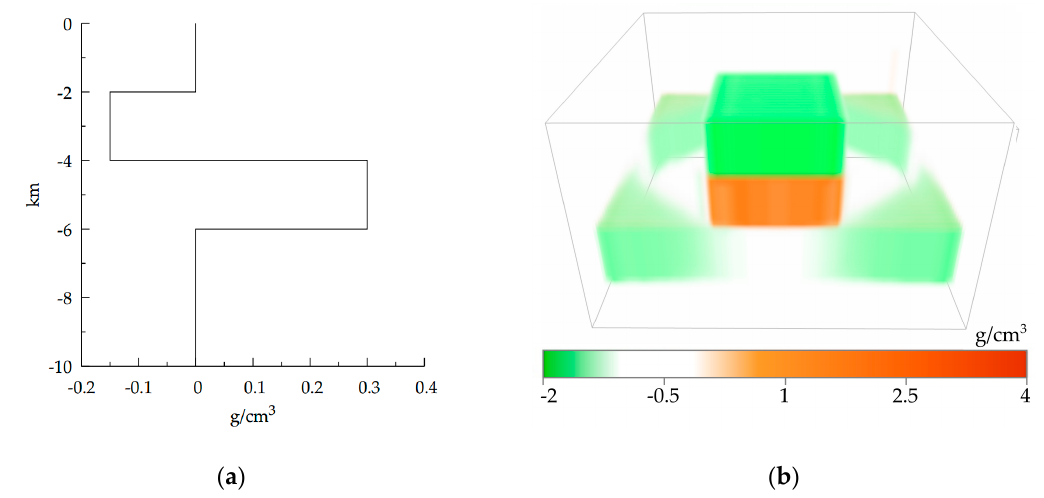
Figure 8. Synthetic example modification #3: ( a ) Background density distribution ρ 0 ( z ) and ( b ) Linear problem inverse solution, which is based on it.